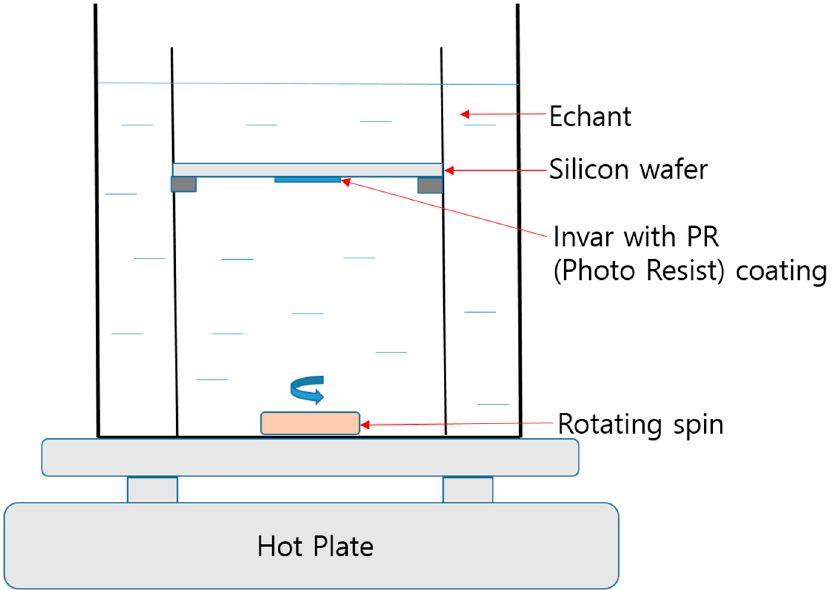
Figure 5. Schematic diagram of wet etching system.